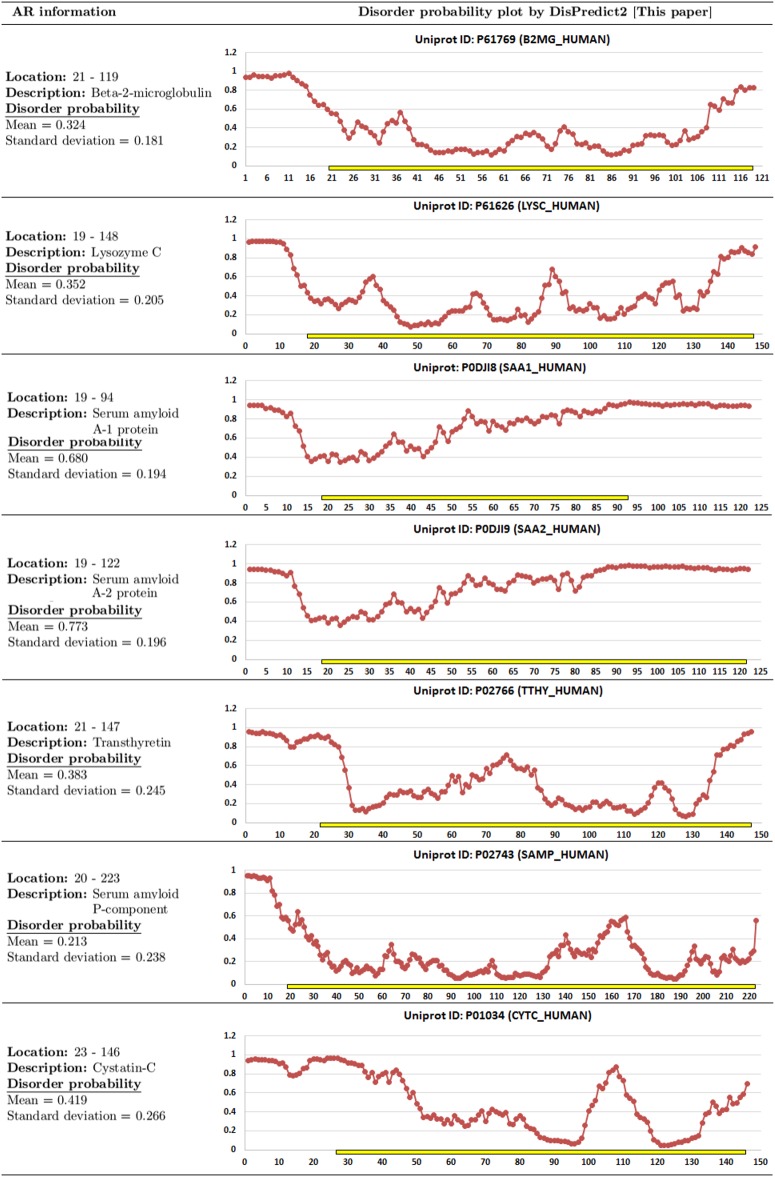
List of proteins with amyloidogenic regions (ARs) and the disorder probability plots given by DisPredict2.The yellow bar indicates the ARs and the red line shows the disorder probability of each residue indicated by circle marker. The description of protein, location of AR are given on the left side each plot along with the mean and standard deviation of disorder probability for the AR.